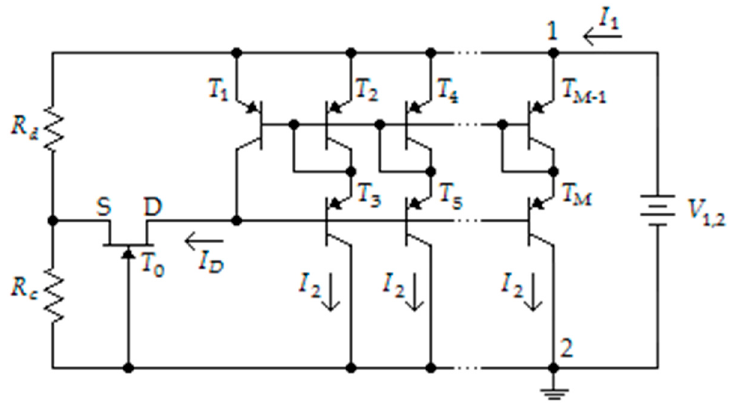
Figure 4. Two-terminal NDR circuit with multiple-output Wilson current mirror.